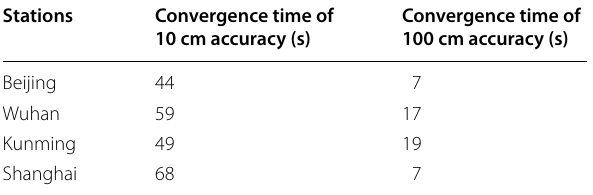
Table 5 Convergence time of PPP-B2b Stations Convergence time of 10 cm accuracy (s)